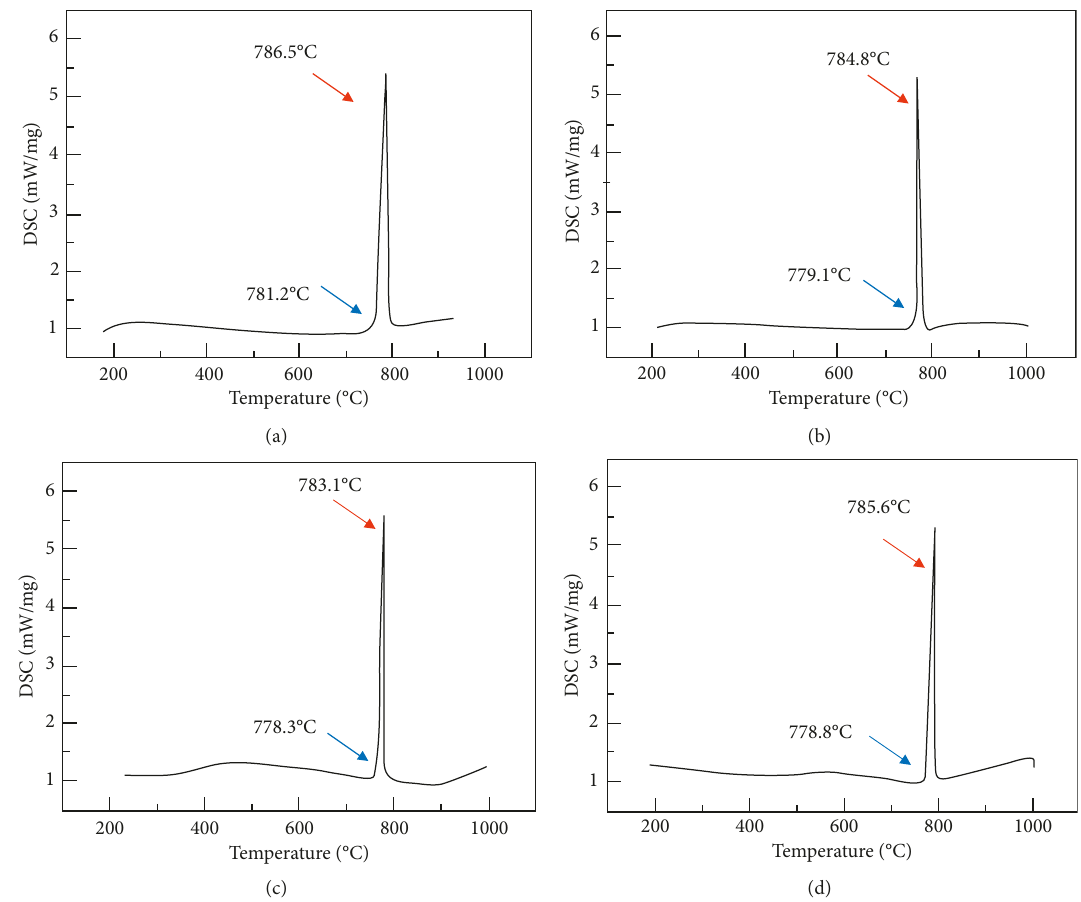
� 0; (b) x � 0.03; (c) x � 0.05; (d) x � 0.1. 2 composites: (a) x